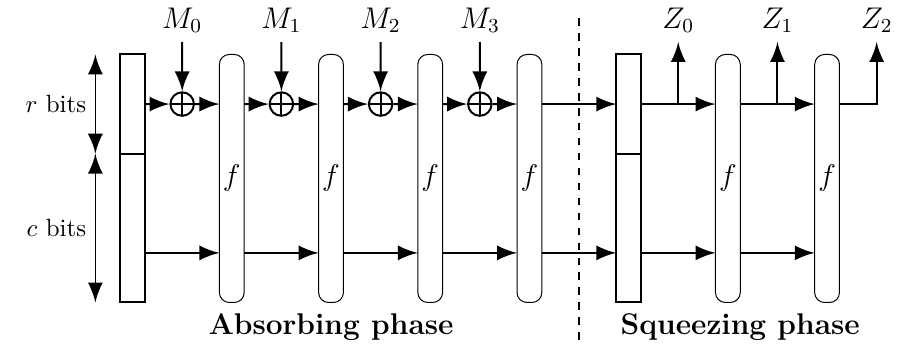
Figure 1: The Sponge